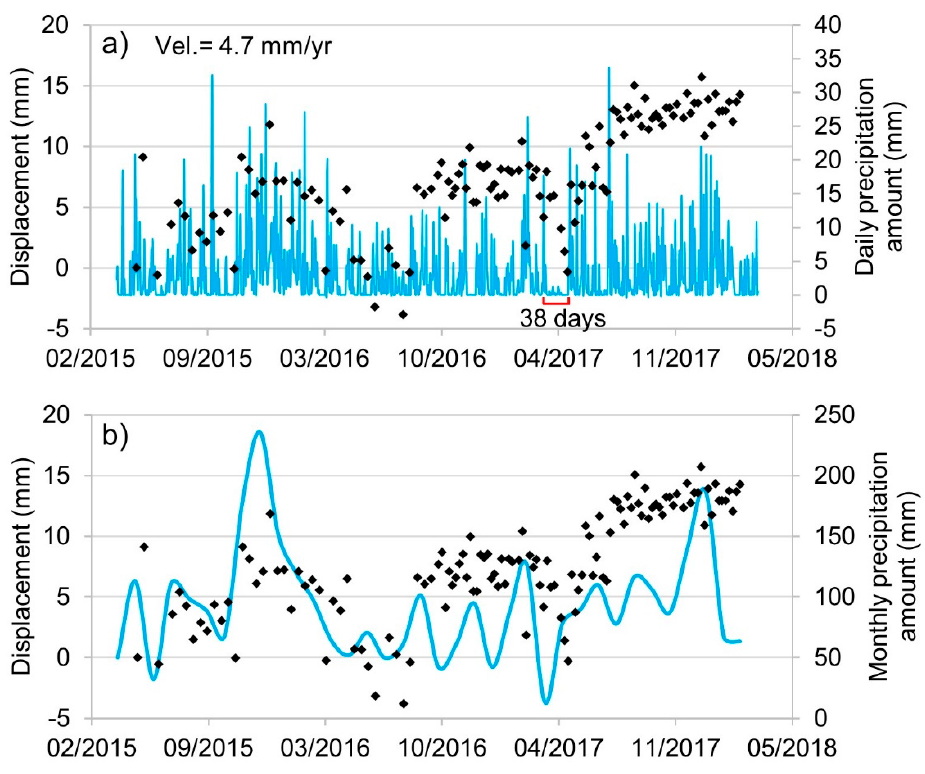
Figure 16. InSAR-derived displacement time series for the center of raised bog vs. precipitation. The data shown here are extracted for the point 3 of Figure 15a. The blue curves represent ( a ) the daily and ( b ) the monthly precipitation amount. Precipitation data obtained from the Carndolla weather station, located 5 km north of the peat area (available from [60] ).